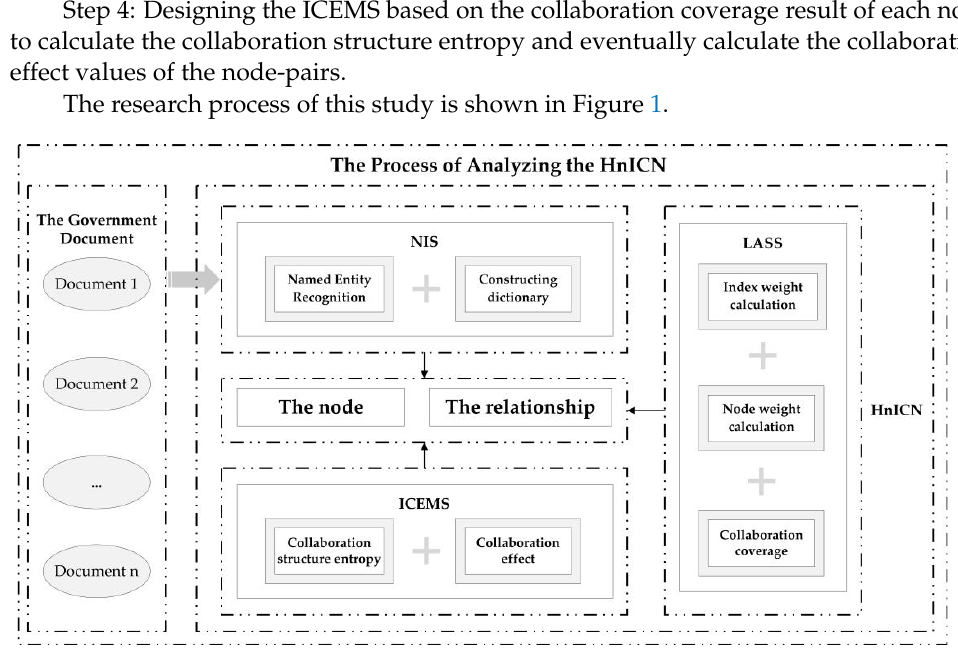
Figure 1. The process of analyzing the HnICN.